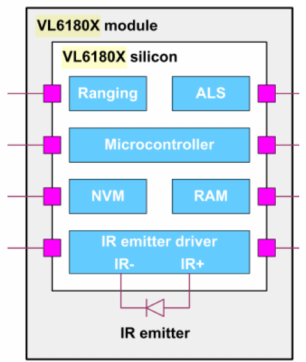
Figure 14. Architecture of ST Microelectronics VL6180X SOC LiDAR [91].